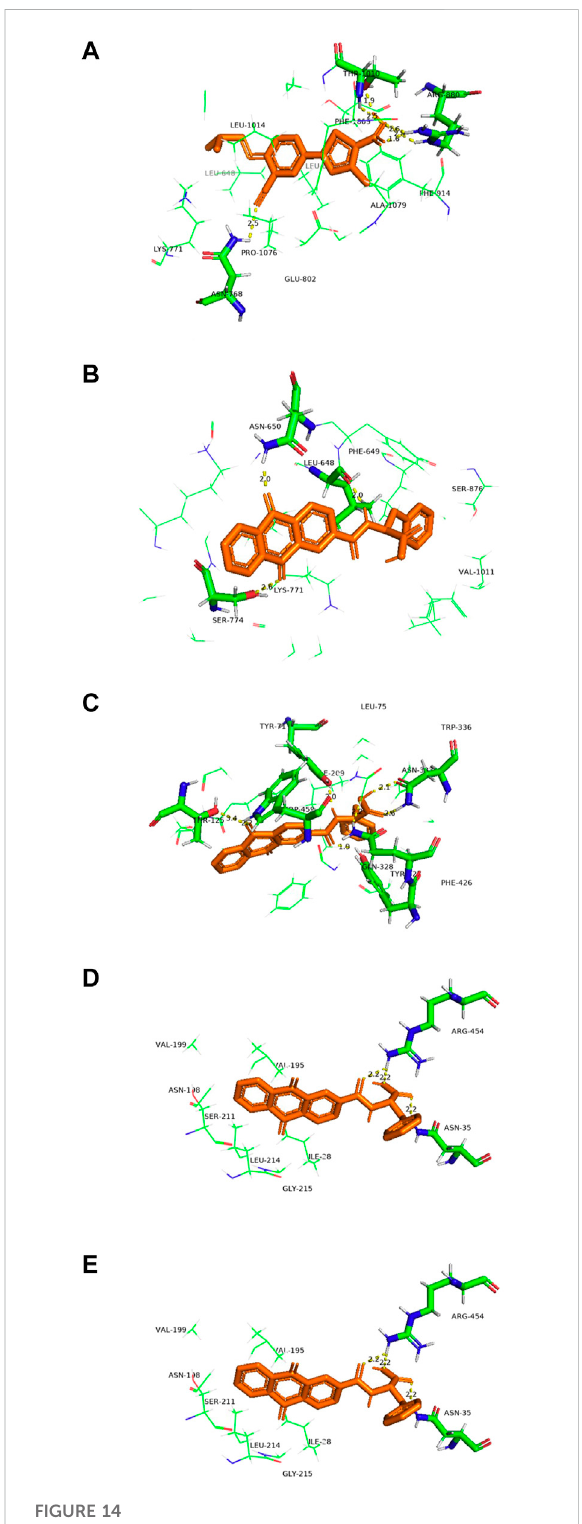
FIGURE 14 Active binding sites of NAY with receptor protein. [ (A) Binding mode of XOD and febuxostatl. (B) Binding mode of XOD and NAY. (C) Binding mode of GLUT9 and NAY. (D) Binding mode of OAT1 and NAY. (E) Binding mode of OAT3 and